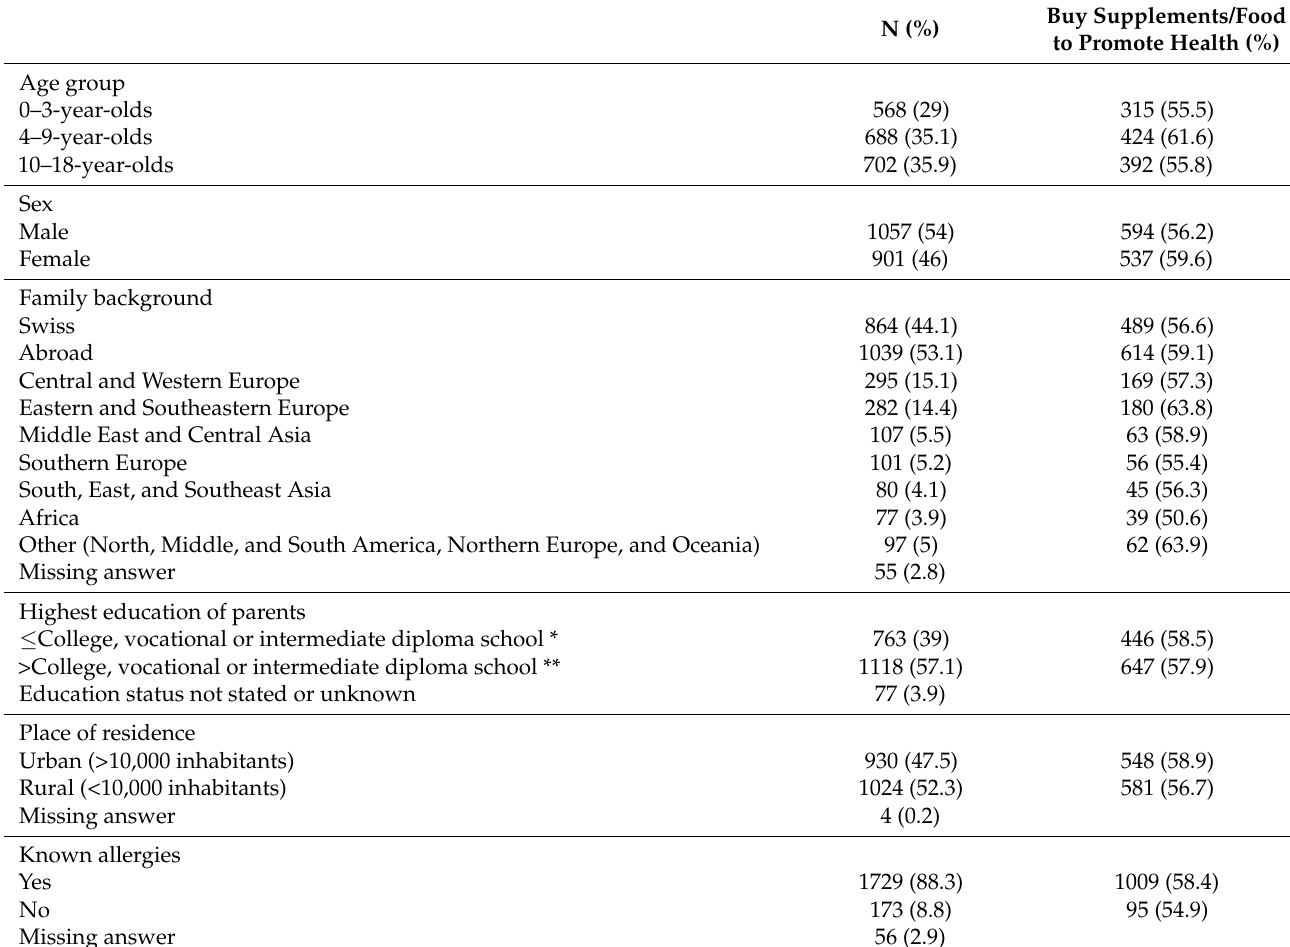
Table 1. Characteristics of participants (n = 1958).